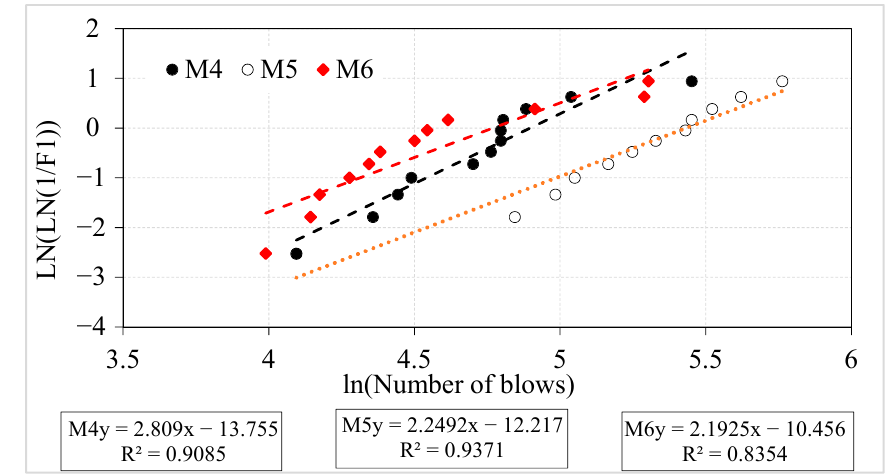
Figure 5. Weibull lines for mixes M4, M5, and M6. Table 4. Computed Weibull parameters.